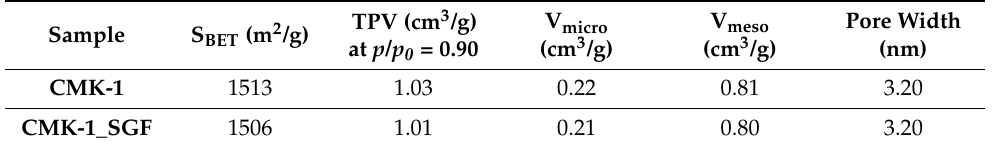
Table 1. Pore properties of the CMK-1 carbon spheres before and after incubation with SGF (pH = 1.2).